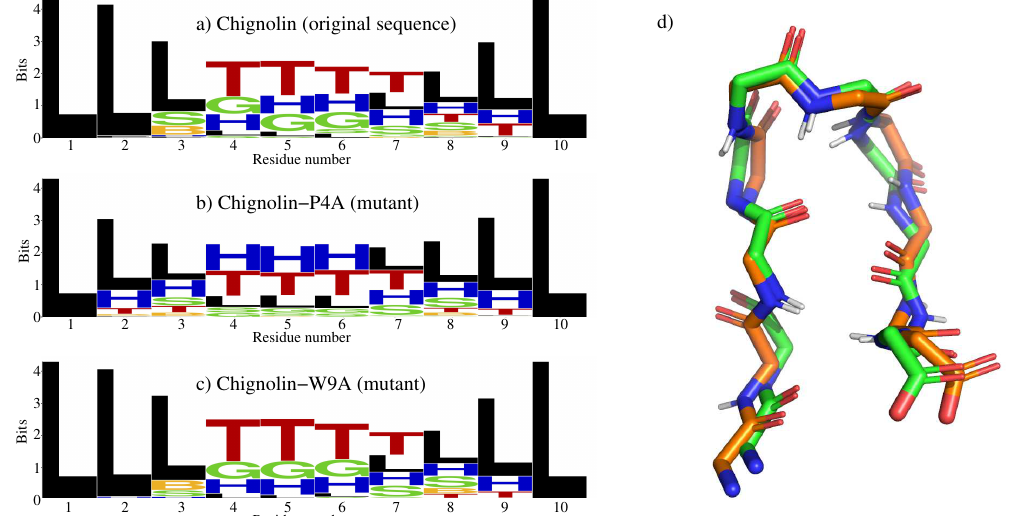
Figure 1. The left side panel represents the structural propensities at the residue level observed from a set of 1000 conformations randomly generated from the structural database. Each plot displays the DSSP structural classes using the WebLogo format for ( a ) Chignolin, and two mutants: ( b ) Chignolin-P4A, and ( c ) Chignolin-W9A. ( d ) Structural representation of Chignolin: superposition of an experimentally determined structure (with carbon atoms in green) and the closest one in the set of 1000 sampled conformations (with carbon atoms in orange). For clarity, only the protein backbone is represented, using PyMOL [39].